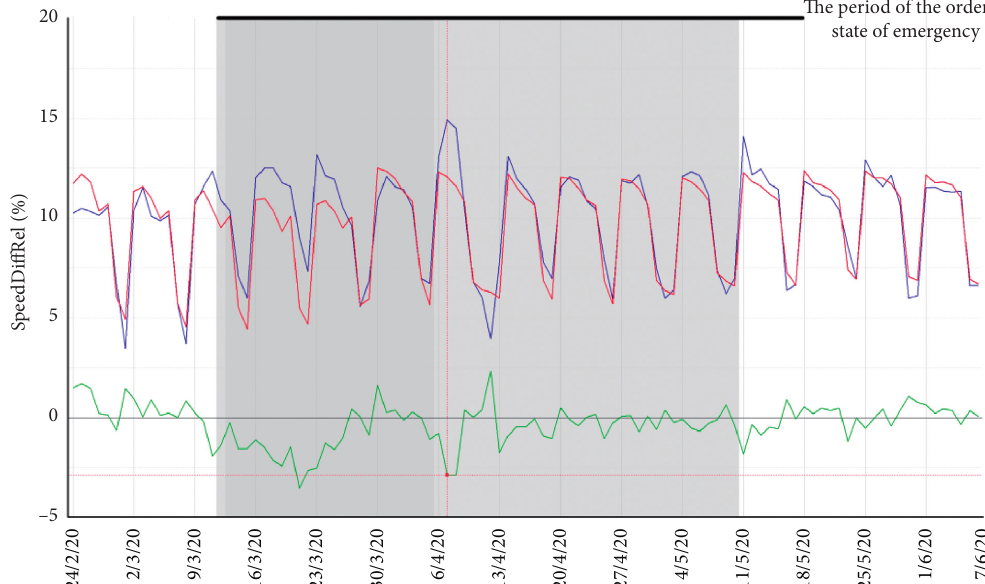
Figure 7: Deviation of the measured and predicted speed values from FreeFlowSpeed for motorways in the period from 24 February to 7 June 2020. These are the daily average